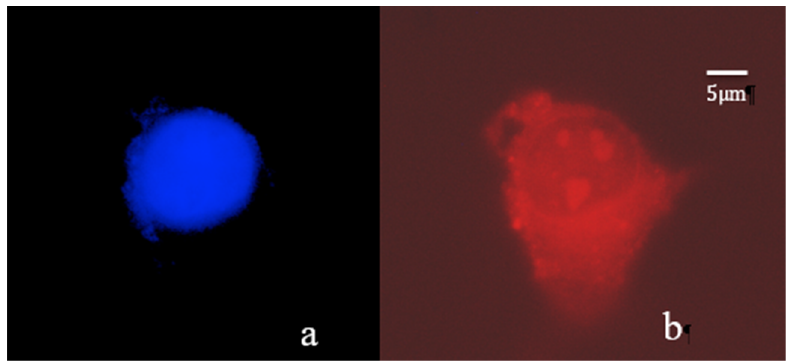
Figure 7. Confocal microscopy visualization of nucleus and cytoplasm of the same cell with Compound 5 of tumoral U-251 cell line using lasers at: 405 nm ( a ); and 560 nm ( b ).